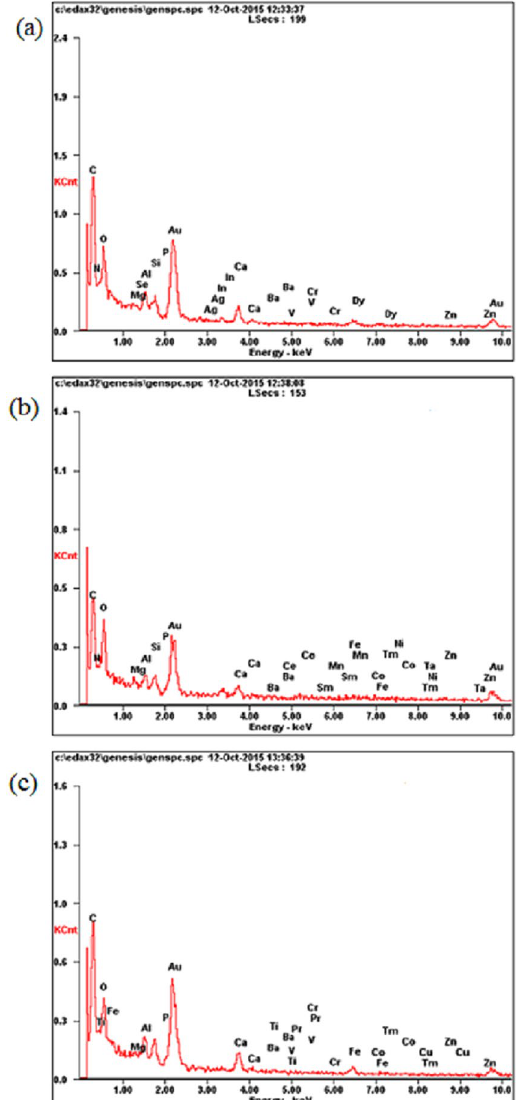
Figure 1. EDX images of sludge samples from W1 ( a ), W2 ( b ) and W3 ( c ) collected in February